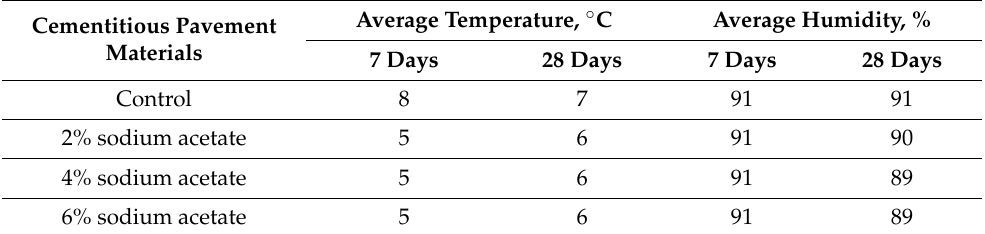
Table 1. Average 7 and 28 days recorded temperature and humidity for samples cured in natural environment (outdoor).